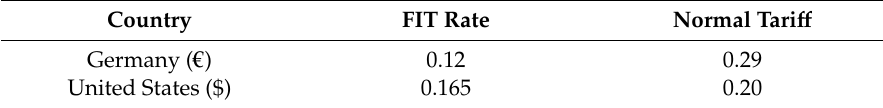
Table 1. Feed-in tari ff (FIT) and normal tari ff